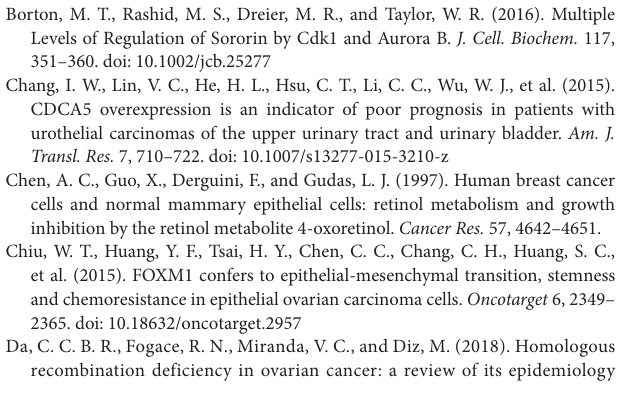
sUPPlEMEnTArY FIgUrE 1 | Volcano map of DEGs on the basis of |fold change| > 1 and a corrected P-value <0.05. (A) GSE27651 (B) GSE38666 © GSE40595 (D) GSE66957. Red dots represented the upregulated DEGs. Green dots represented the down-regulated DEGs. Black dots represented noDEGs. sUPPlEMEnTArY FIgUrE 2 | Hierarchical clustering heatmap of top 200 DEGs. (A) GSE27651 (B) GSE38666 © GSE40595 (D) GSE66957. Red indicates that the expression of genes is relatively upregulated, green indicates that the expression of genes is relatively downregulated, and black indicates no significant changes in gene expression. sUPPlEMEnTArY FIgUrE 3 | The survival analysis based on stage I-II and stage III-IV. The one on the left in the figure was survival analysis based on stage I-II, the right one was stage III-IV. sUPPlEMEnTArY FIgUrE 4 | ROC analysis between stage I-II and stage III-IV.